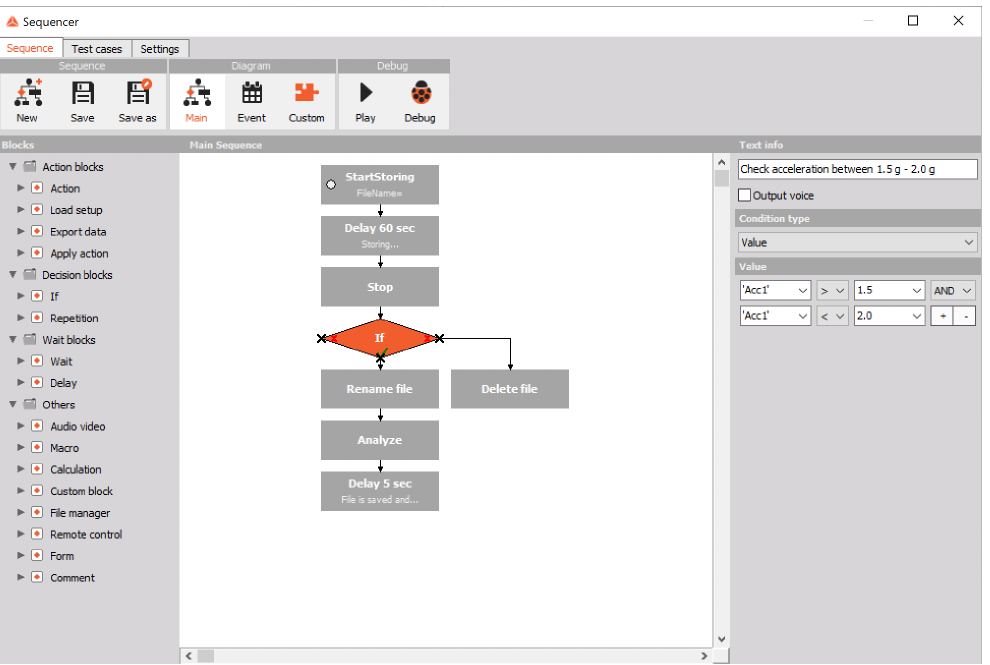
Figure 2. The DEWESoft’s modeling